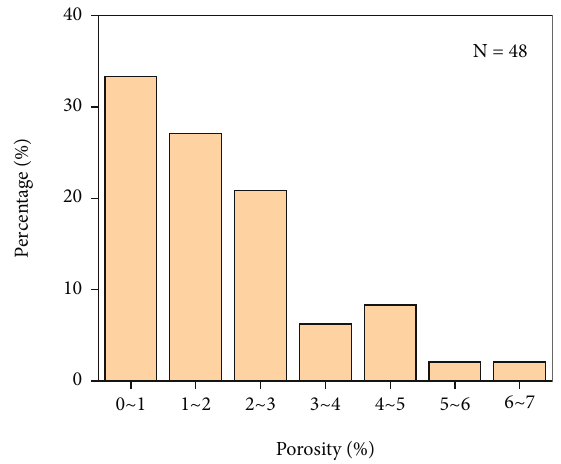
Figure 9: Histogram showing the frequency distribution of porosity.